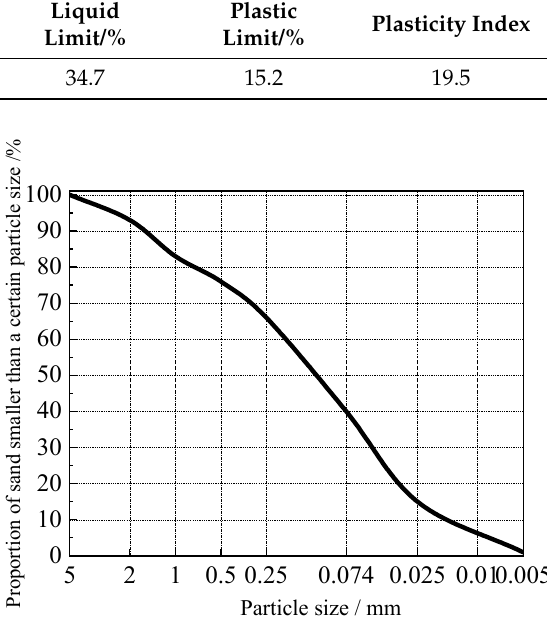
Figure 1. Grain gradation test results.